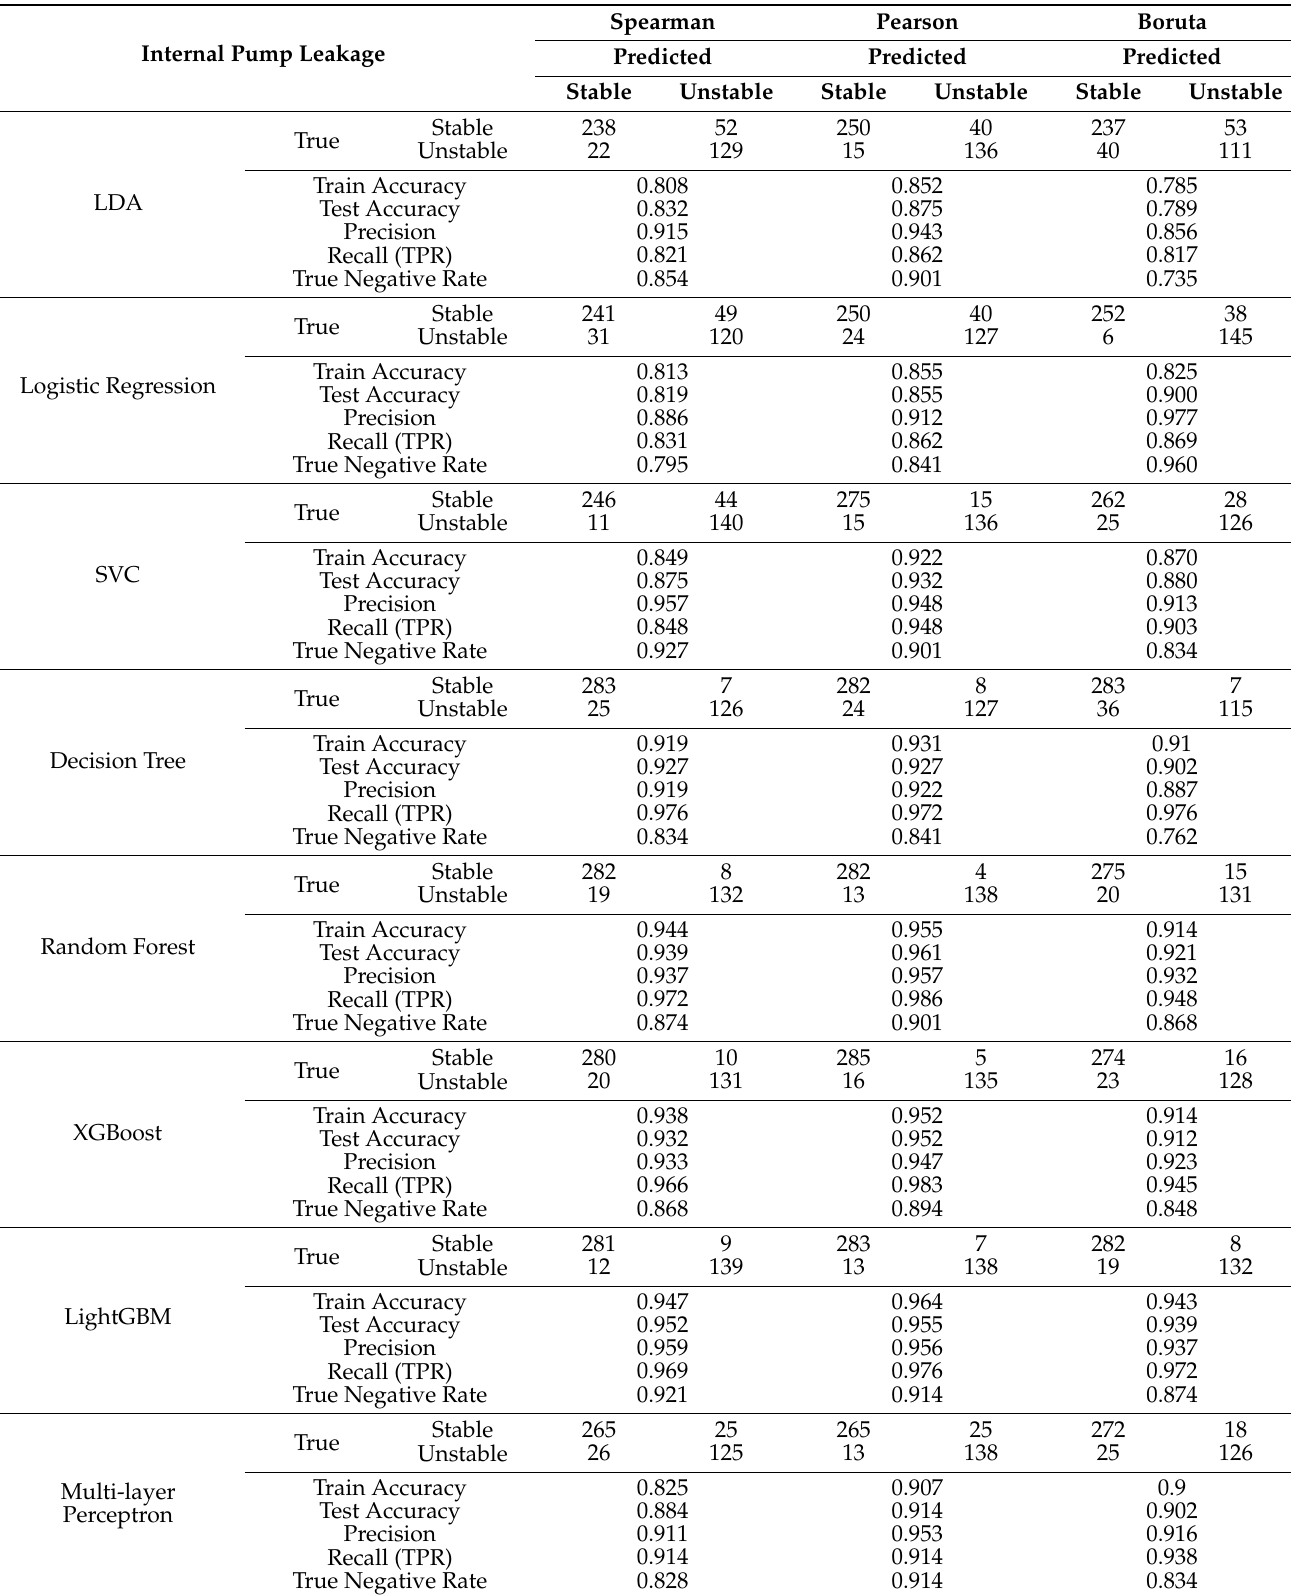
Table 10. Classification evaluation metrics for internal pump